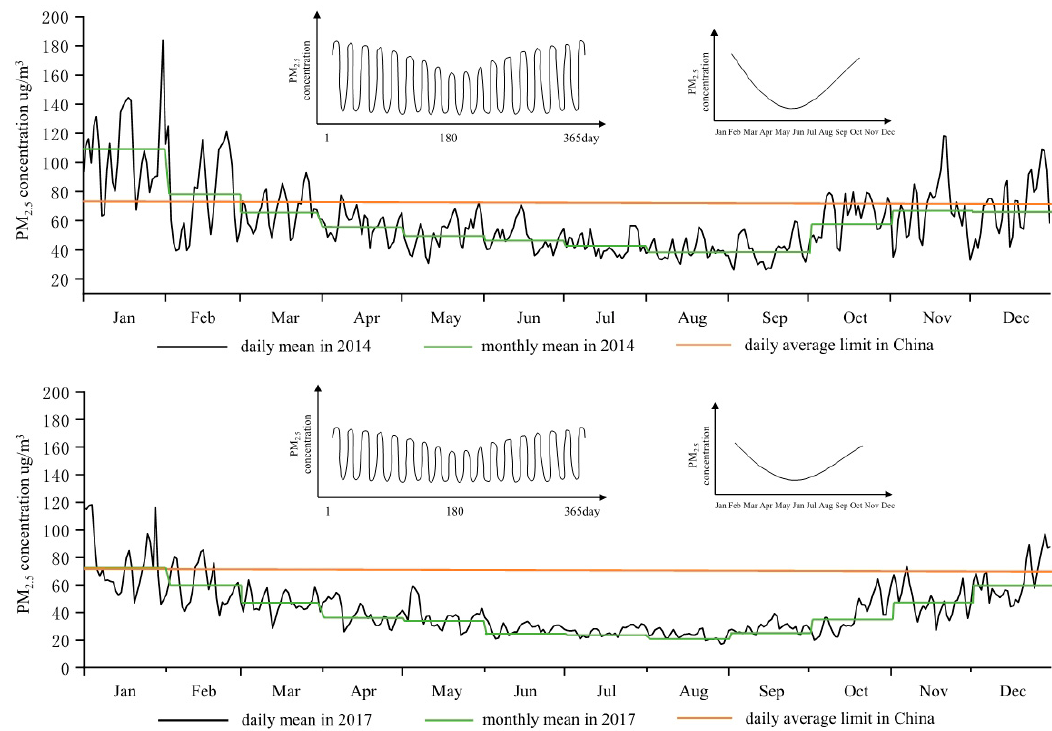
Figure 2. Daily and monthly mean values of PM 2.5 concentration in 2014 and 2017.